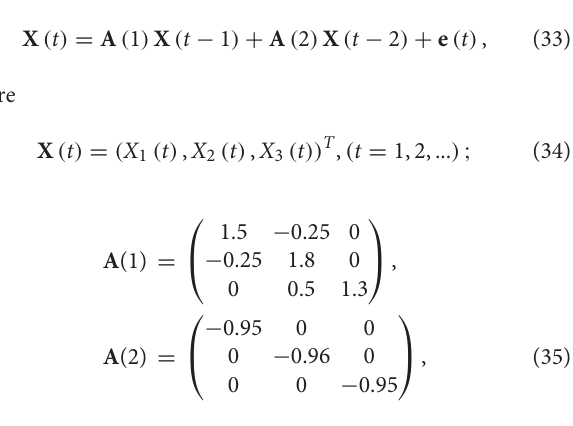
Frontiers in Neuroscience |